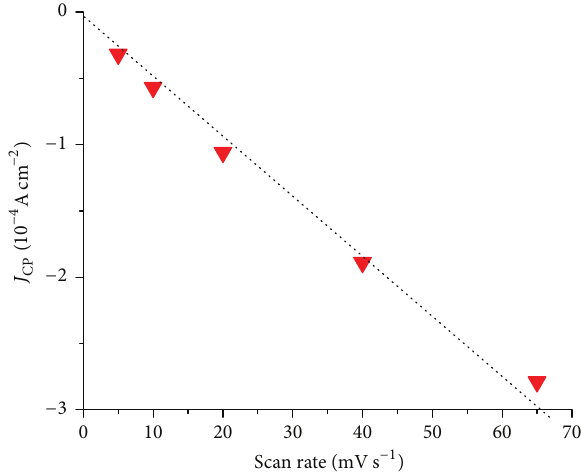
Figure 10: Scan rate dependence of the cathodic peak positioned between 2.9 and 3.1 V versus Li + /Li for the sample of RDS NiO ( 𝑙 = 0.3 𝜇 m) spray-deposited onto ITO. Cell configuration and electrolyte composition as in Figure 1. Data extracted from Figure